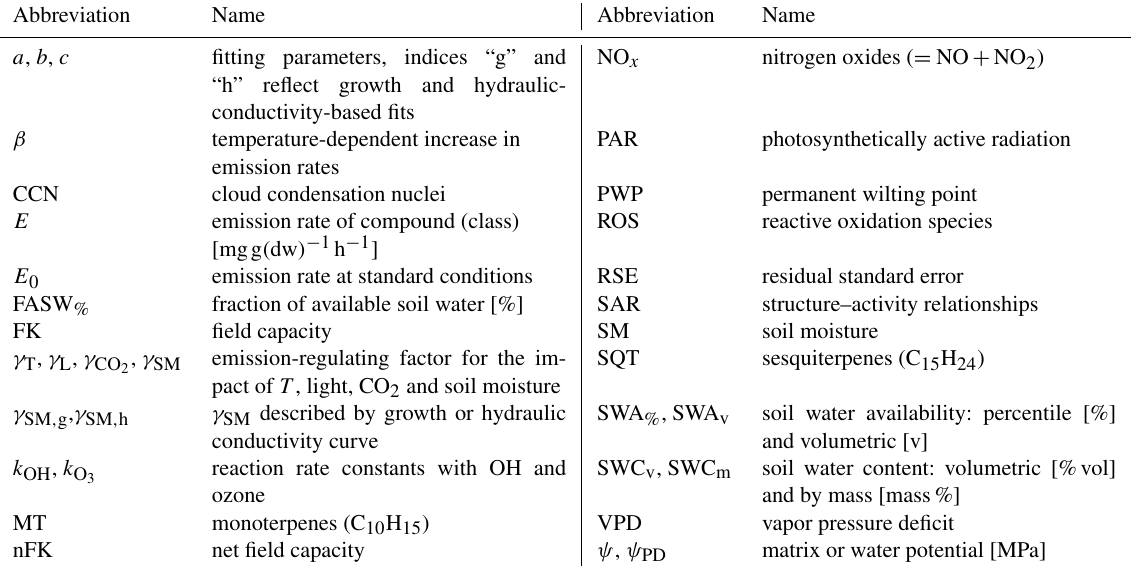
Table 1. Overview of abbreviated terms and parameter